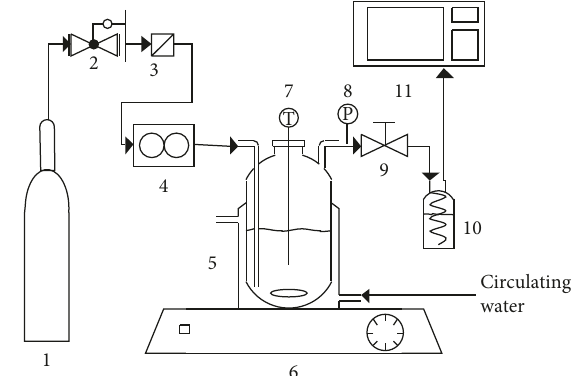
Figure 1: Schematic of the experimental setup for measuring CO solubility.1: High pressure gas cylinder, 2: pressure regulator valve, 3: filter, 4: mass control flowmeter, 5: equilibrium cell, 6: magnetic stirrer, 7: temperature sensor, 8: pressure sensor, 9: backpressure valve, 10: silica gel dryer, and 11: gas